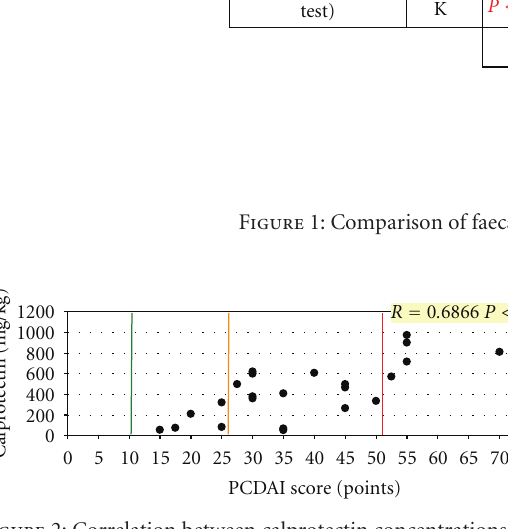
Figure 4: Correlation between calprotectin concentrations and the Rachmilewitz index in children with UC.